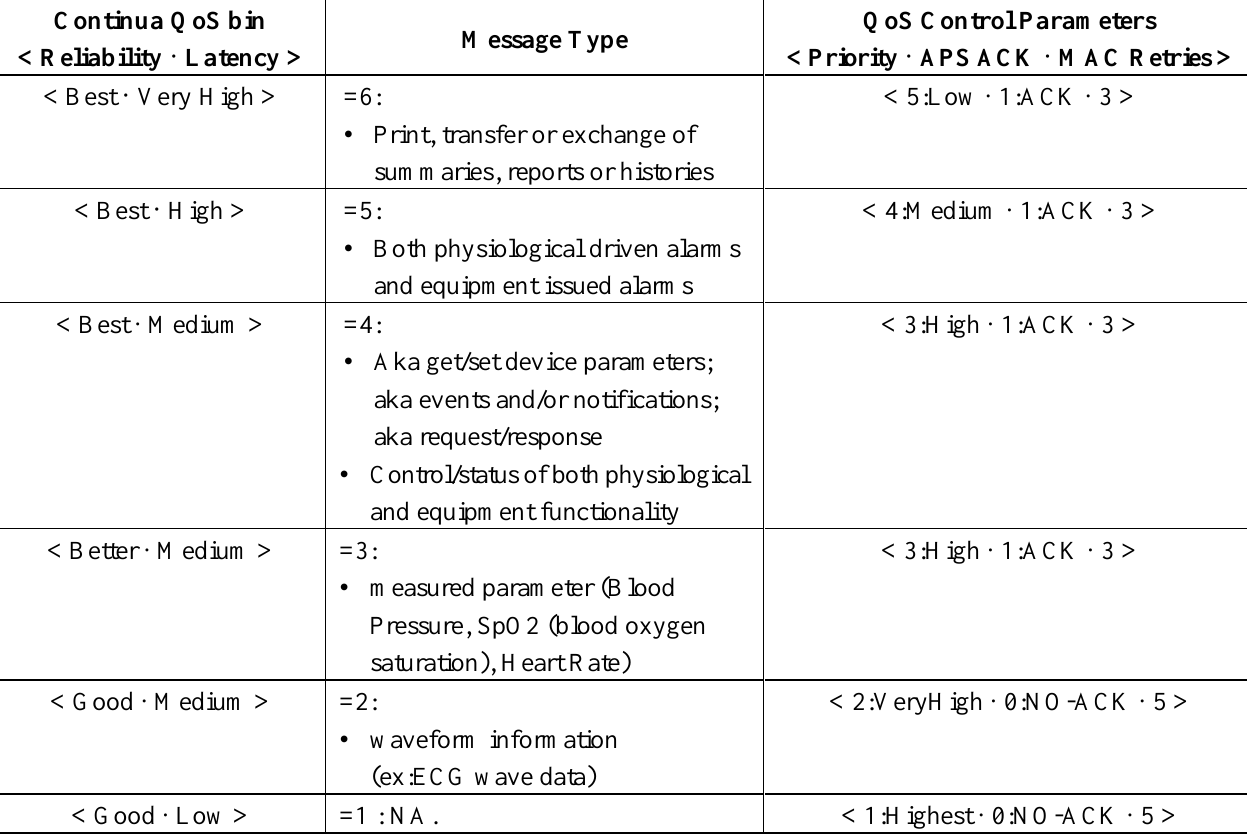
Table 1. Continua QoS bin /Message Type/QoS Parameter Mapping